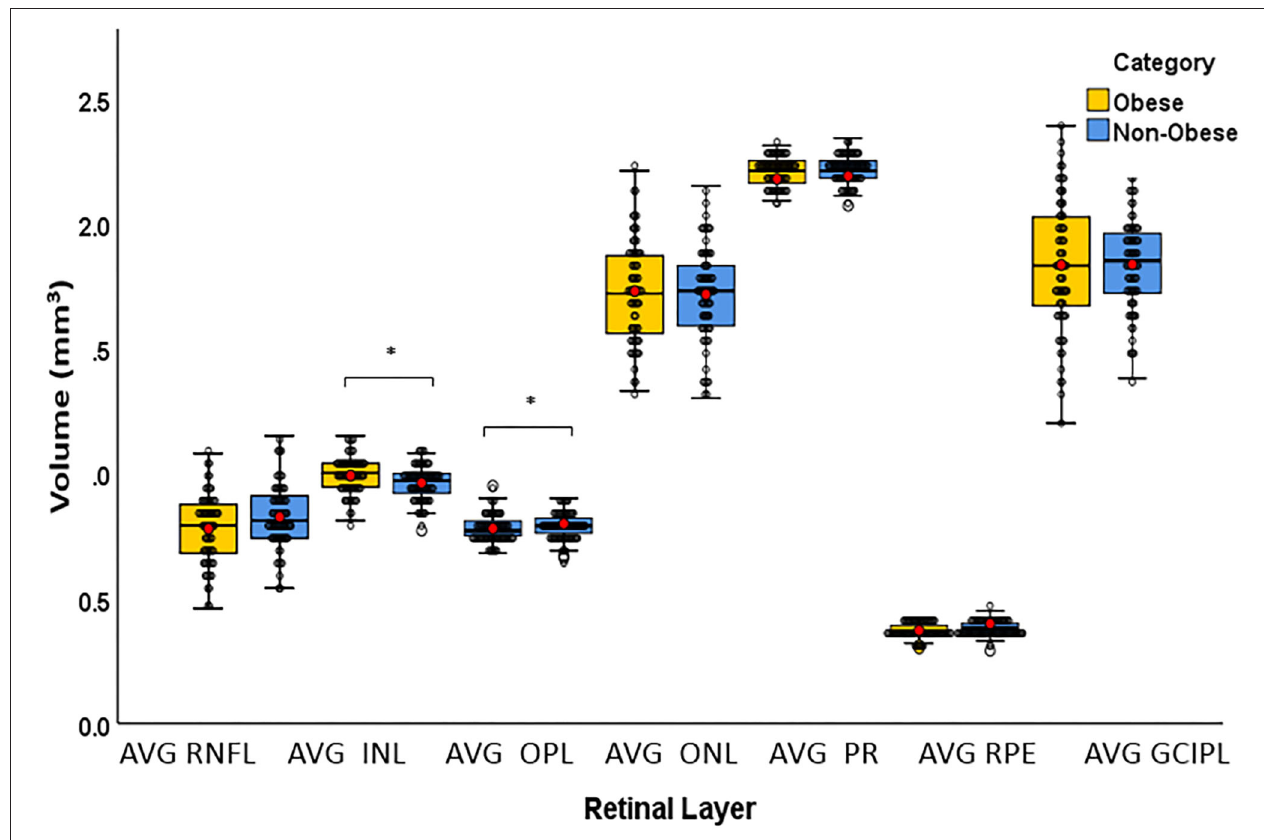
FIGURE 3 | Box plots overlaid with dot plots showing retinal layer volume after intra-retinal segmentation by BMI category (*statistically significant). Red dots represent means. mm 3 , cubic millimeter; BMI, body mass index; RNFL, retinal nerve fiber layer; INL, internal nuclear layer; OPL, outer plexiform layer; ONL, outer nuclear layer; PR, photoreceptor; RPE, retinal pigment epithelium; GCIPL, ganglion cell and internal plexiform layer. *Statistically